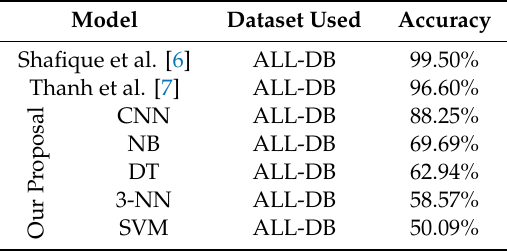
Table 5. A comparison of the binary classification for two literature studies versus our proposal, in terms of average accuracy.